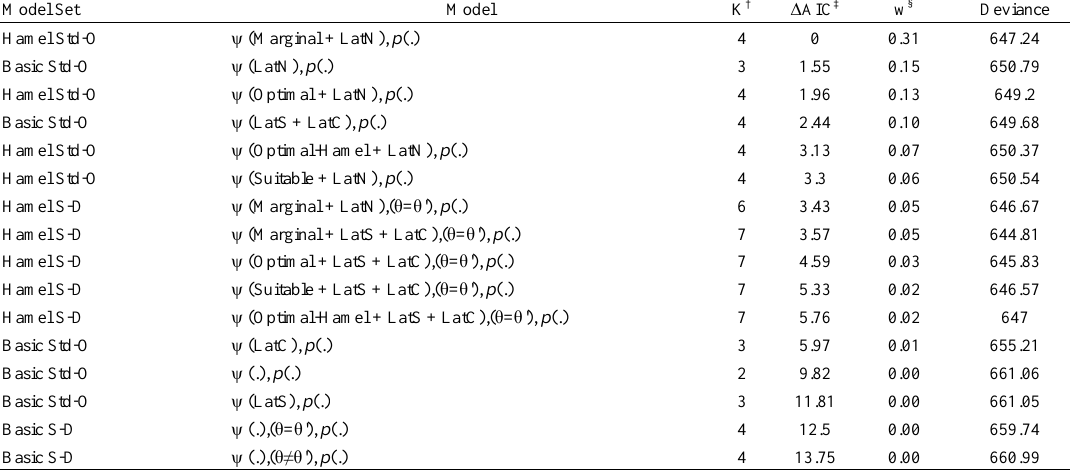
Basic Std-O ψ (LatS + LatC), p